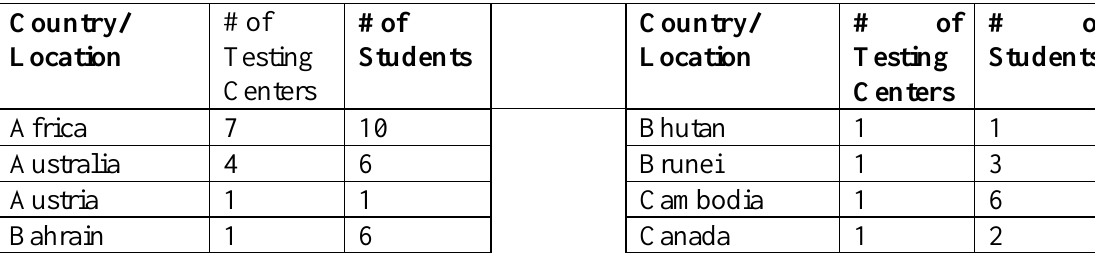
Table 1: Geographical distribution of the UPOU students based outside the Philippines (Second Semester 2009-2010)